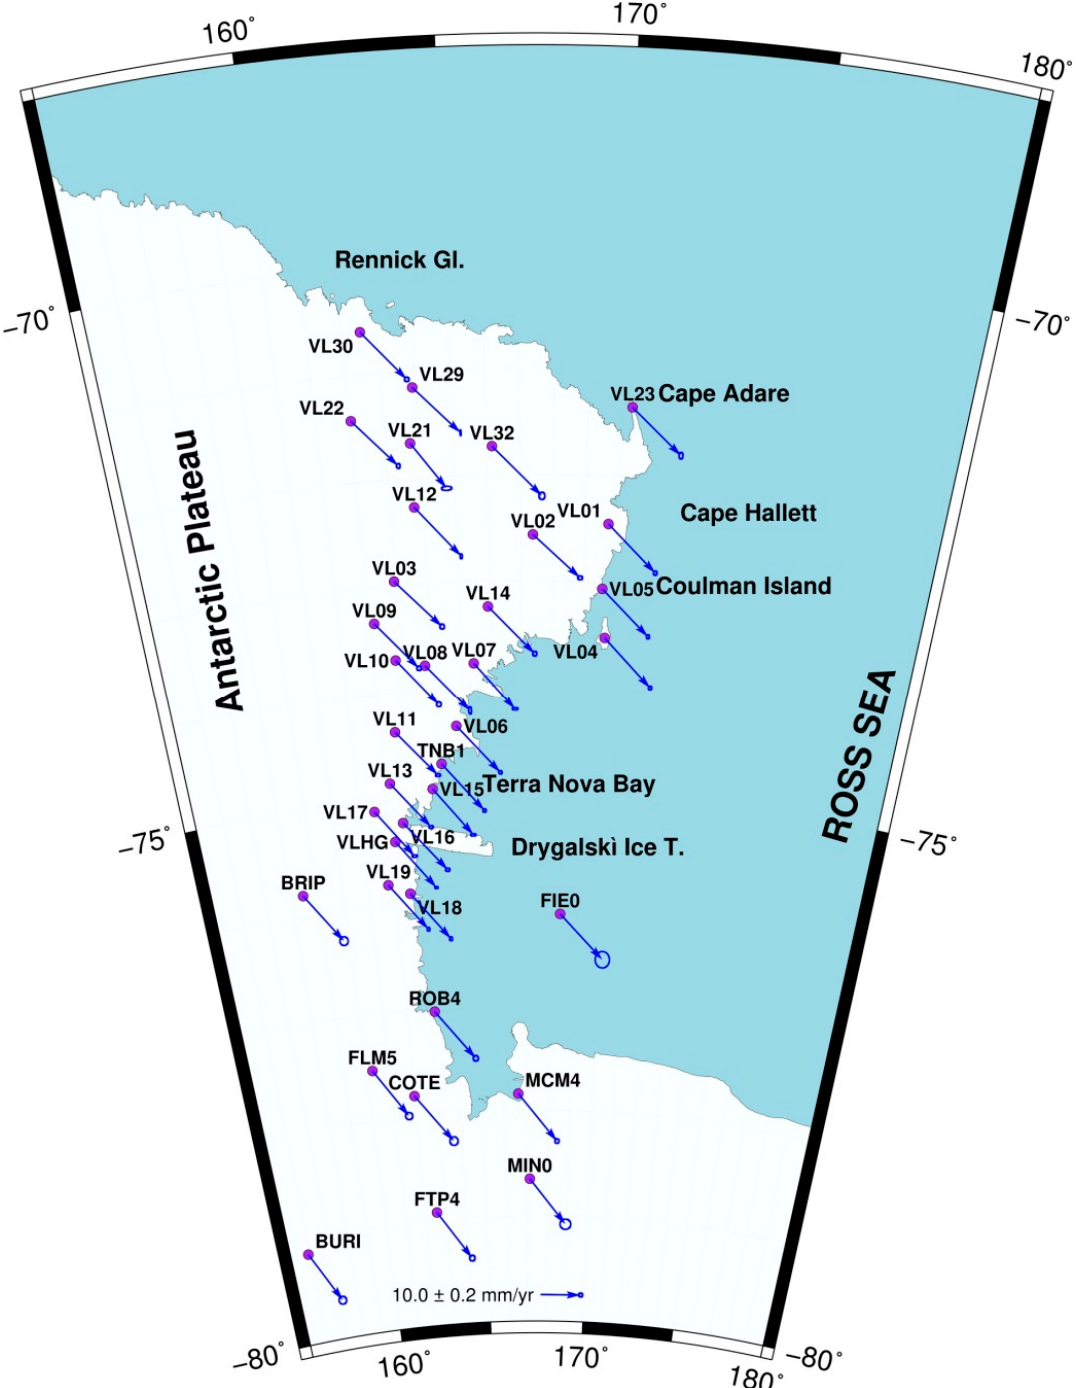
Figure 4. Absolute horizontal displacement map (mm/yr) in Victoria Land (± σ ).